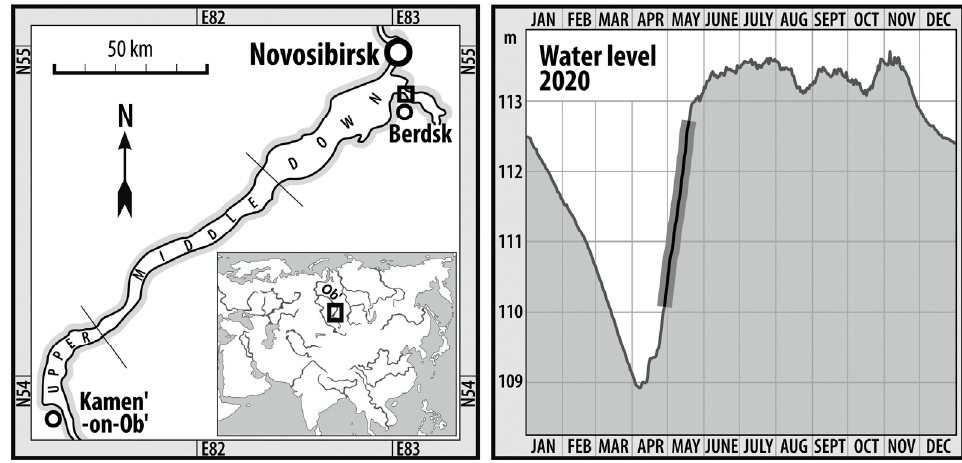
Figure 1. Sampling location and changes in water level of the Novosibirsk reservoir in 2020. Changes in the water level during the field study are highlighted in bold.